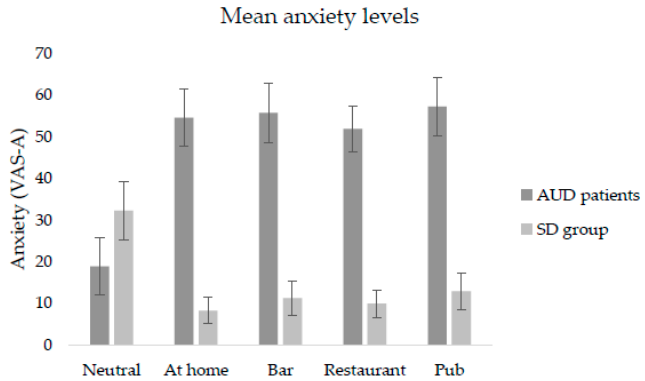
Figure 2. Self-reported mean levels of anxiety (A) on visual analogue scales (VAS)-A.